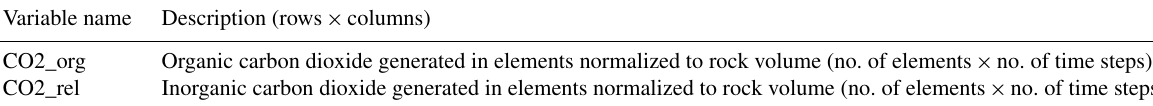
Table 6. List of variables in the “release” struct variable of the output file. Variable